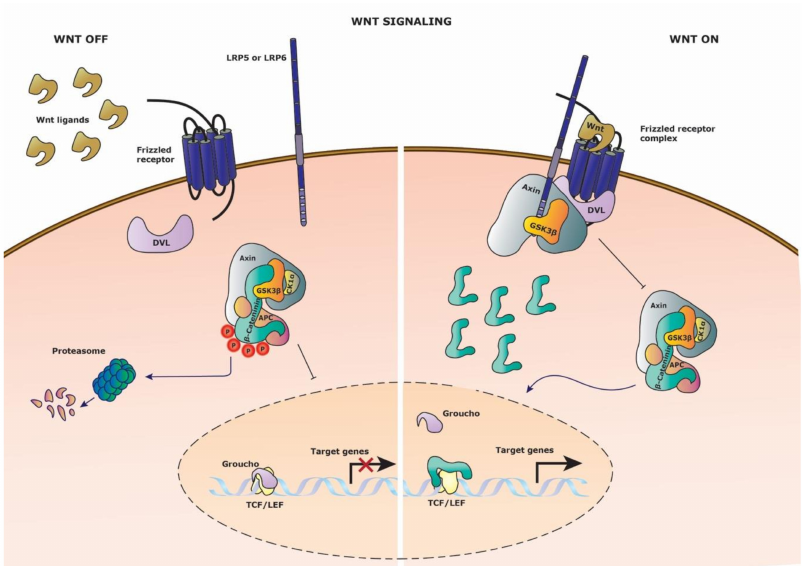
Figure 1. Wnt signaling pathway. Schematic representation of the Wnt signaling pathway. (Left side) Wnt signaling is inactive in the absence of Wnt ligand on the Frizzled receptor. The destruction complex thus can be formed and phosphorylated the constitutively cytosolic β -catenin, leading to proteasomal degradation. Groucho retains its repressor activity by binding the TCF / Lef transcription factors and thus target gene expression is restricted. (Right side) Wnt signaling is activated upon binding of Wnt ligand to the Frizzled receptor and recruitment of the co-receptor LPR5 / 6. Axin, GSK3- β and DVL (Dishevelled) are recruited to the membrane receptor complex, disrupting the destruction complex. Cytosolic β -catenin translocates to the nucleus to compete with Groucho for TCF / Lef transcription factor binding, leading to target gene